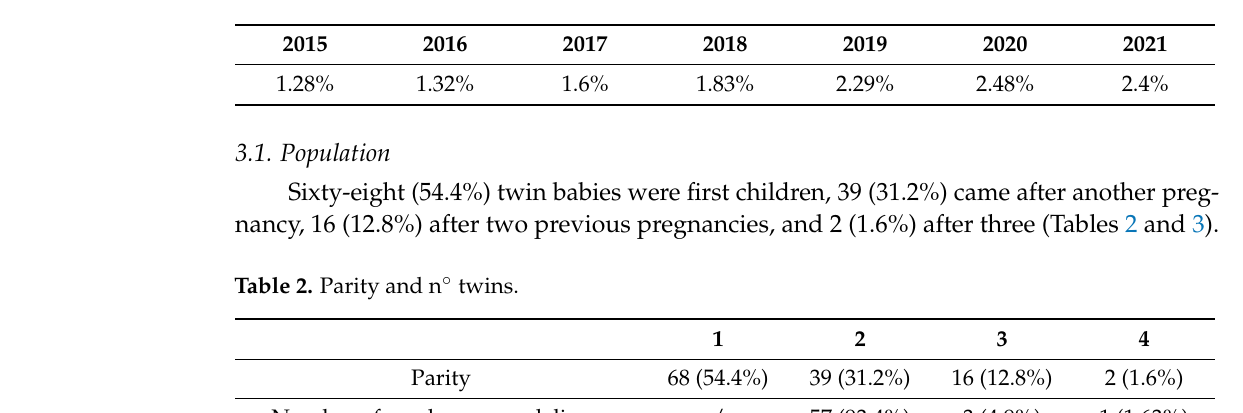
Table 1. Annual incidence of twin births.